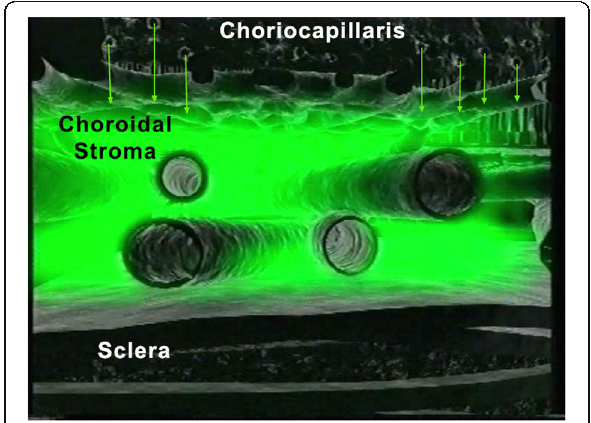
Fig. 2 ICGA. Schematic cartoon showing the progressive impregnation of the choroidal stroma by the ICG-macromolecular complex egressing from the choriocapillaris (green